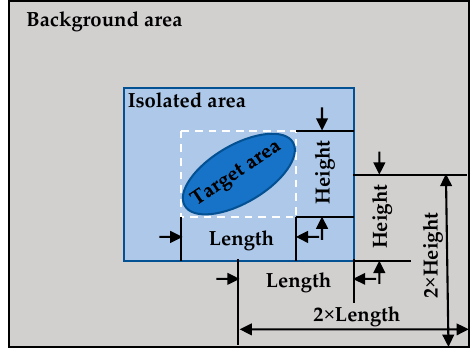
Figure 4. Definition of correlation region of signal-to-noise ratio (SNR).